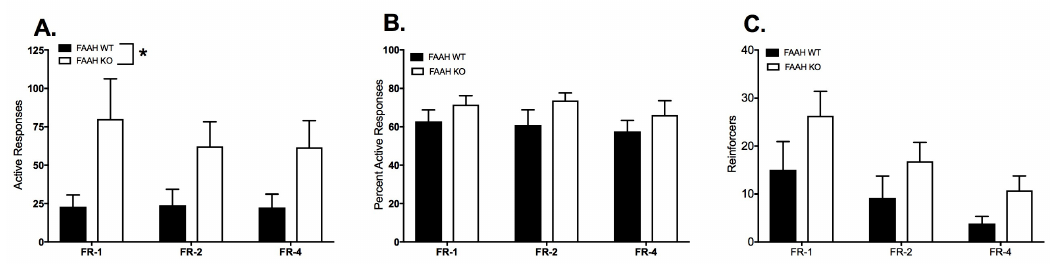
Figure 5. Comparison of FR-1-4 responses and reinforcers earned in WT ( n = 9; filled bars) and FAAHKO ( n = 13; open bars) mice. Bars represent mean ± SEM. ( A ) Mean responses in the active port; ( B ) Mean percent of total responses made in the active port; ( C ) Mean reinforcers earned. * p < 0.05. After FR-4, all subjects were advanced to PR for three sessions; the average responses and reinforcers across the 3 sessions are shown in Figure 6. There was no significant difference between the groups in reinforcers earned or in the breakpoint during the PR paradigm (Figure 6A; t 20 = 1.64, p = 0.117). The percent of responses in the active port were not different between the genotypes (Figure 6B; Mann Whitney U = 55, p = 0.845).